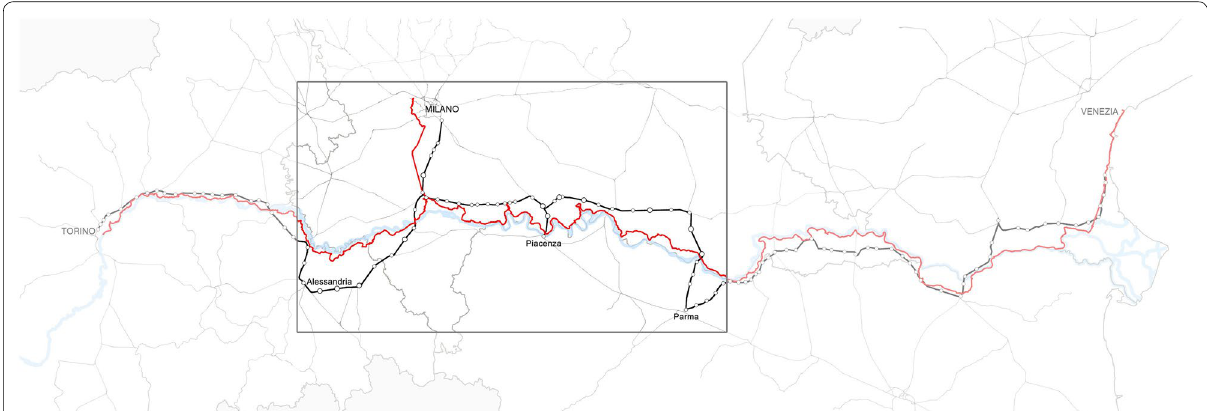
Fig. 2 Part of VENTO path considered in the project, included between Parma, Piacenza, Milano and Alessandria. [Scale 1:1.150.000]